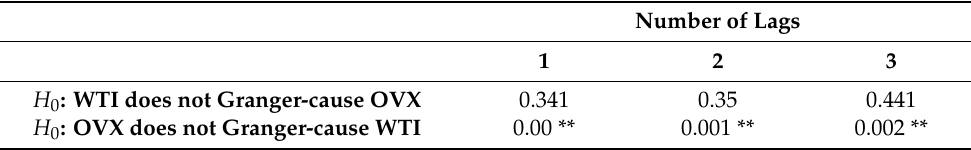
Table 6. p -values of the standard test of Granger causality (in mean).